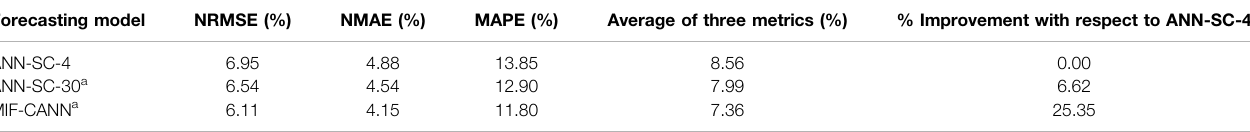
TABLE 6 | Simulation results of 2 h-ahead wind speed forecasting of the three forecasting approaches. Forecasting model